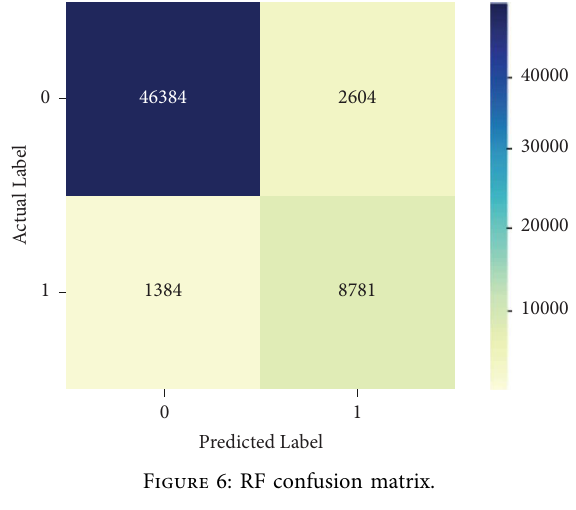
Figure 6: RF confusion matrix.